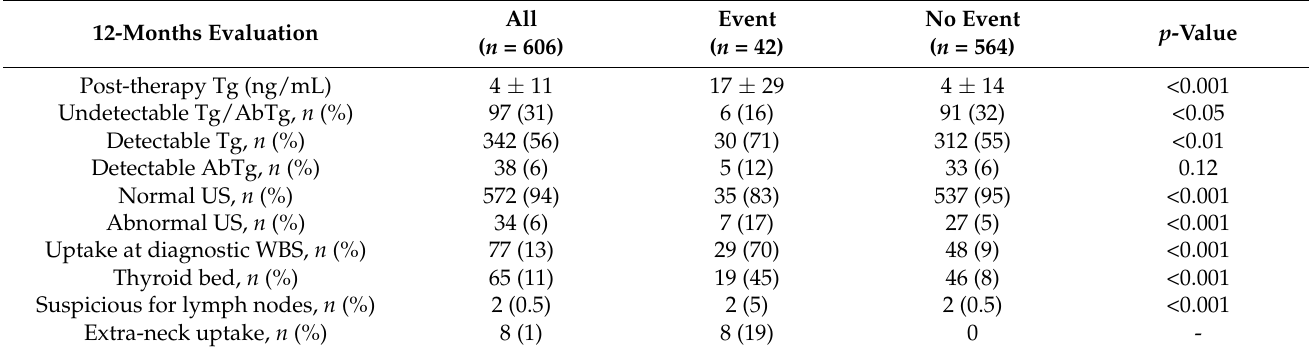
Table 2. Characteristics of the study population at 12 months evaluation according to